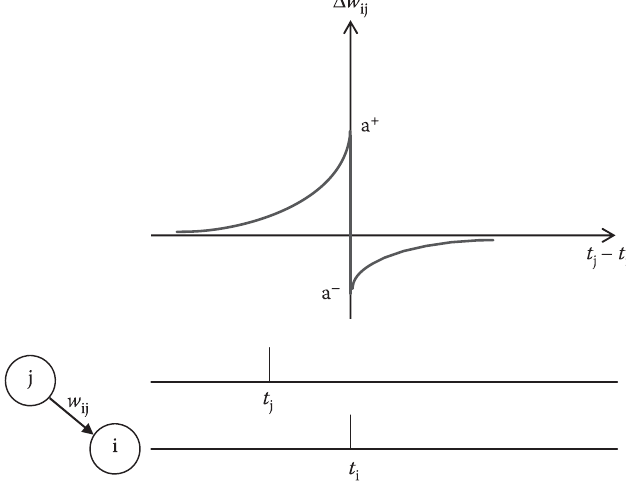
Figure 30. Pre ‐ synaptic spike and post ‐ synaptic spike for spike ‐ timing dependent plasticity (STDP) learning.